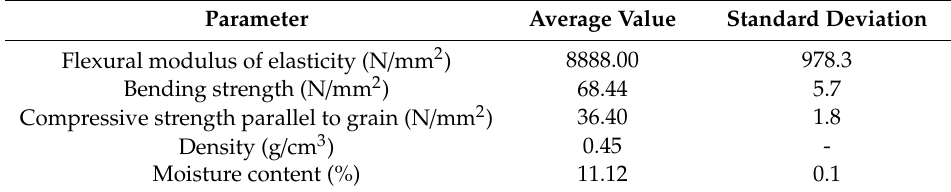
Table 3. Material properties of carbon fiber-reinforced polymer (CFRP) from the manufacturers.